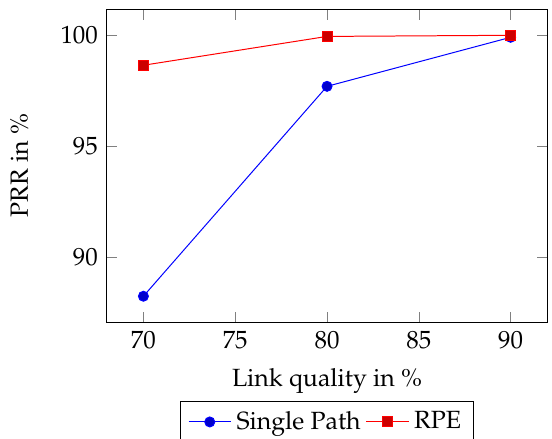
Figure 9. Packet reception ratios for Single Path and RPE.